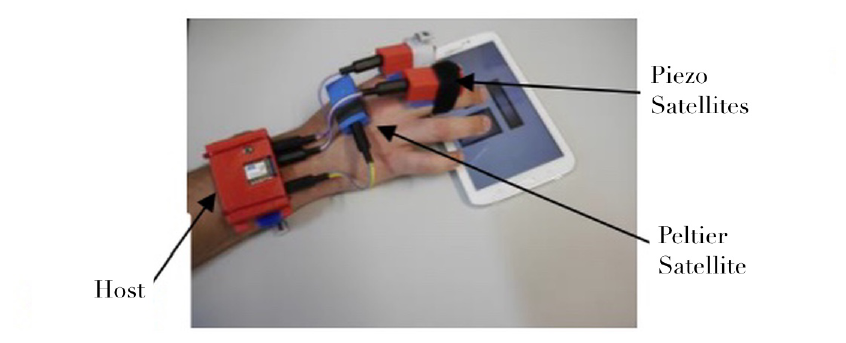
Figure 3. Example of assembly on active hand with one base, two piezoelectric and one